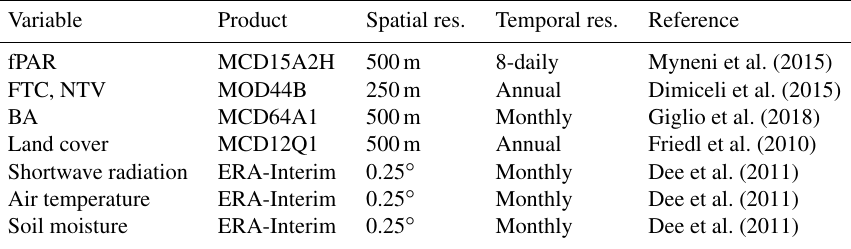
Table 2. Overview of model input